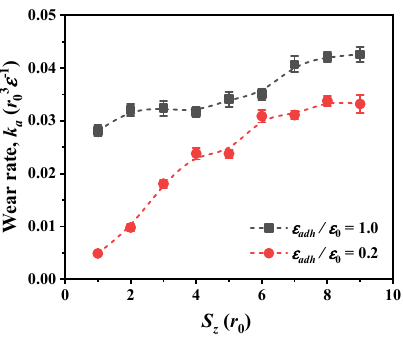
Figure 7. Wear rate for two adhesion ratios at different scratch depths in material of r c = 1.22 r 0